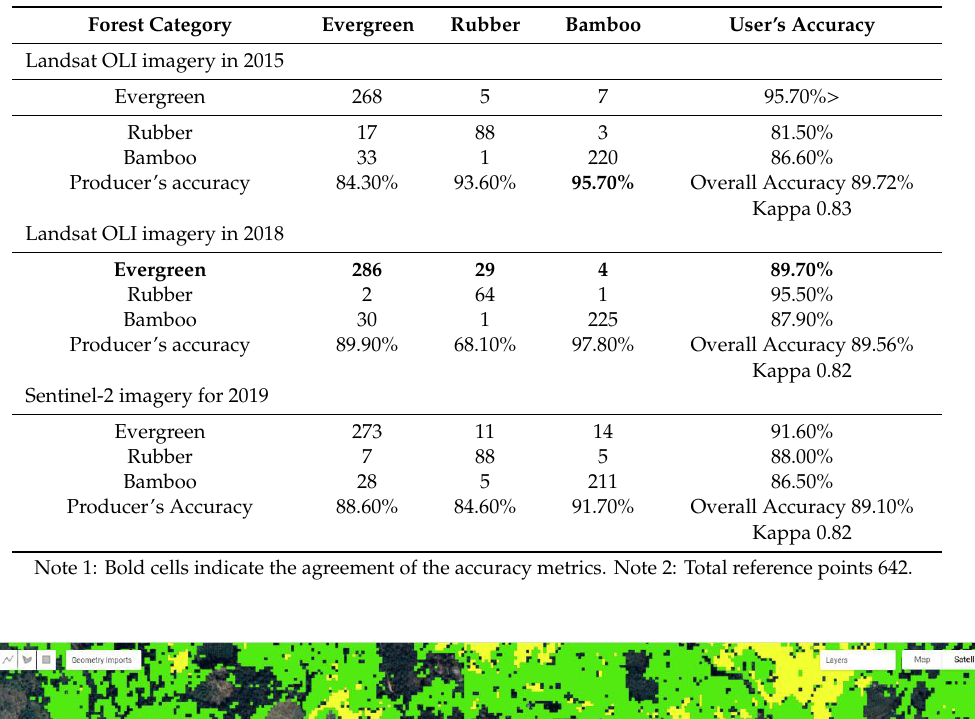
Table 3. User’s accuracy and producer’s accuracy assessment for classifying the bamboo, rubber, and evergreen forest in Siem Reap.